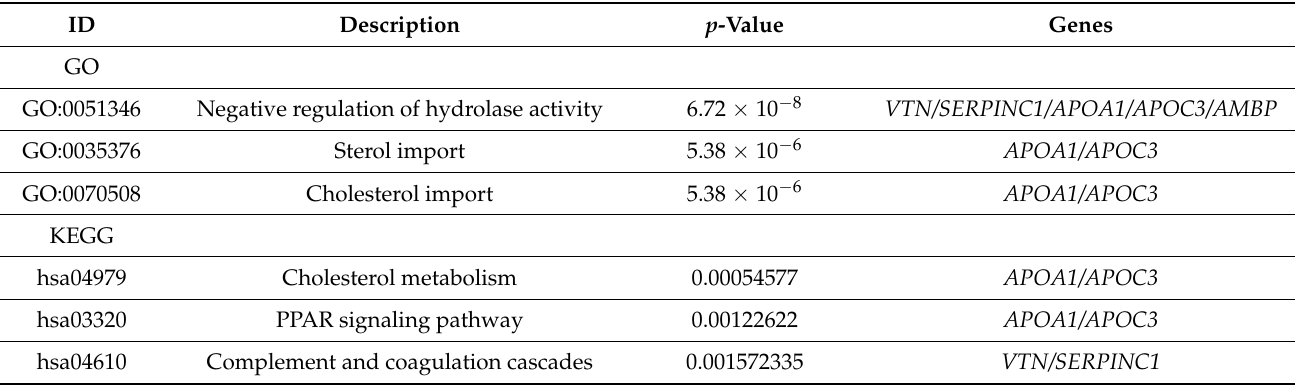
Figure 9. The PPI network and two submodules. ( A ) PPI network of the DEGs. ( B ) Stacked bar chart of top 30 hub genes. ( C ) PPI network of module 1. ( D ) PPI network of module 2. Table 1. Functional annotations of module 1.